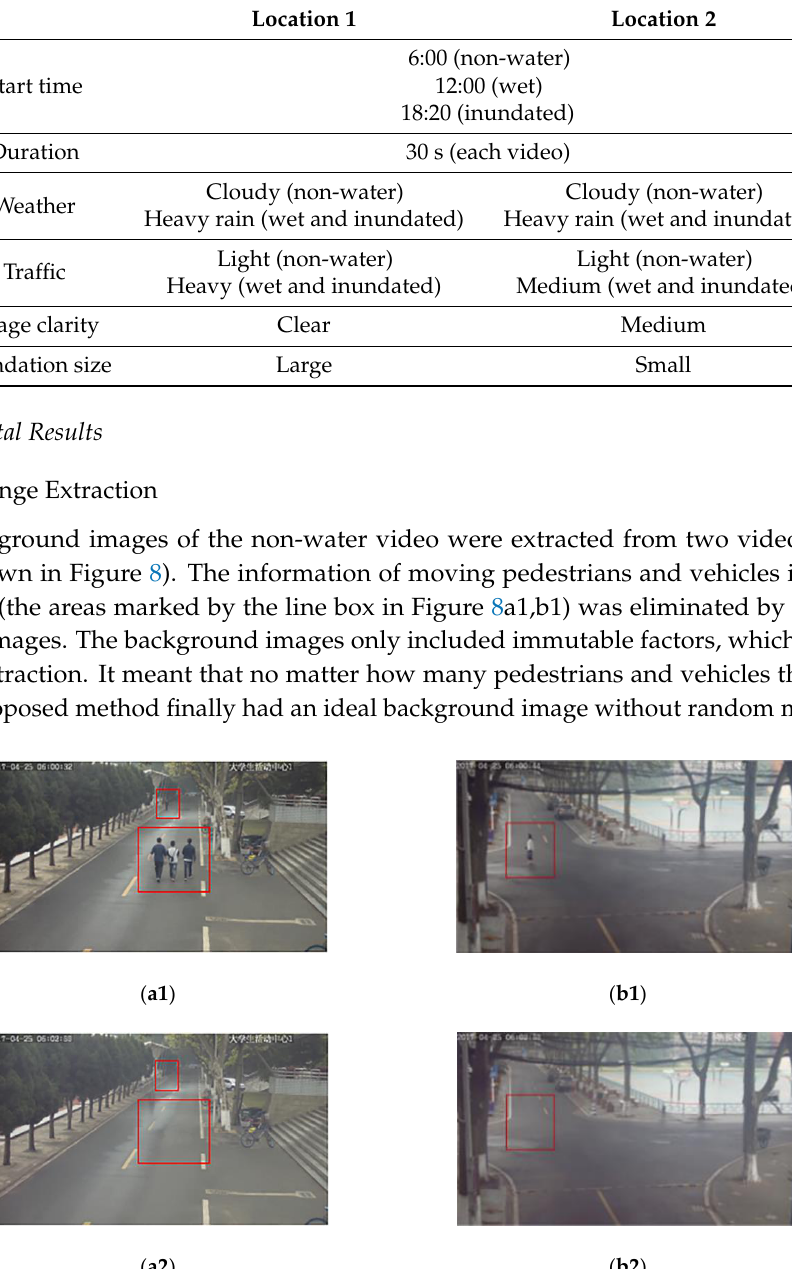
Table 1. Video Data Properties.